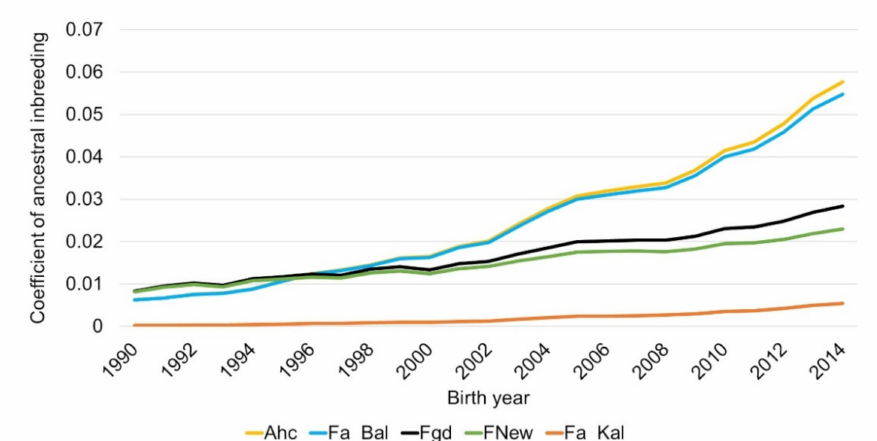
Figure 3. Ancestral inbreeding according to Ballou (F a_Bal ), ancestral (F a_Kal ) and new (F New ) inbreed- ing according to Kalinowski and ancestral history coefficient according to Baumung (A hc ) as well as individual inbreeding coefficient based on the gene dropping method (F gd ) for German Brown for the birth years 1990 to 2014.